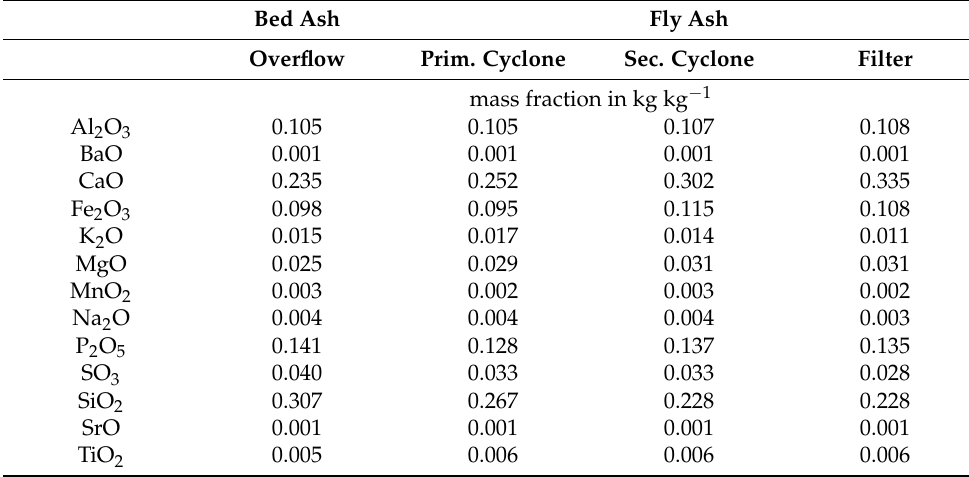
Table 8. Ash main elemental analysis.